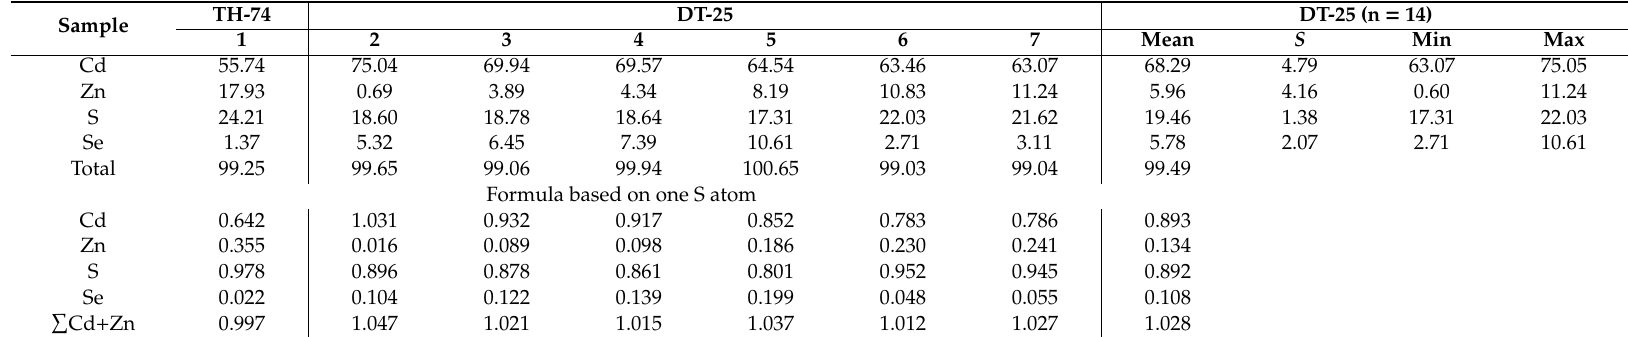
Table 11. Representative analyses and average composition of greenockite from CM marbles, Tulul al Hammam area (SEM-EDS, wt%).